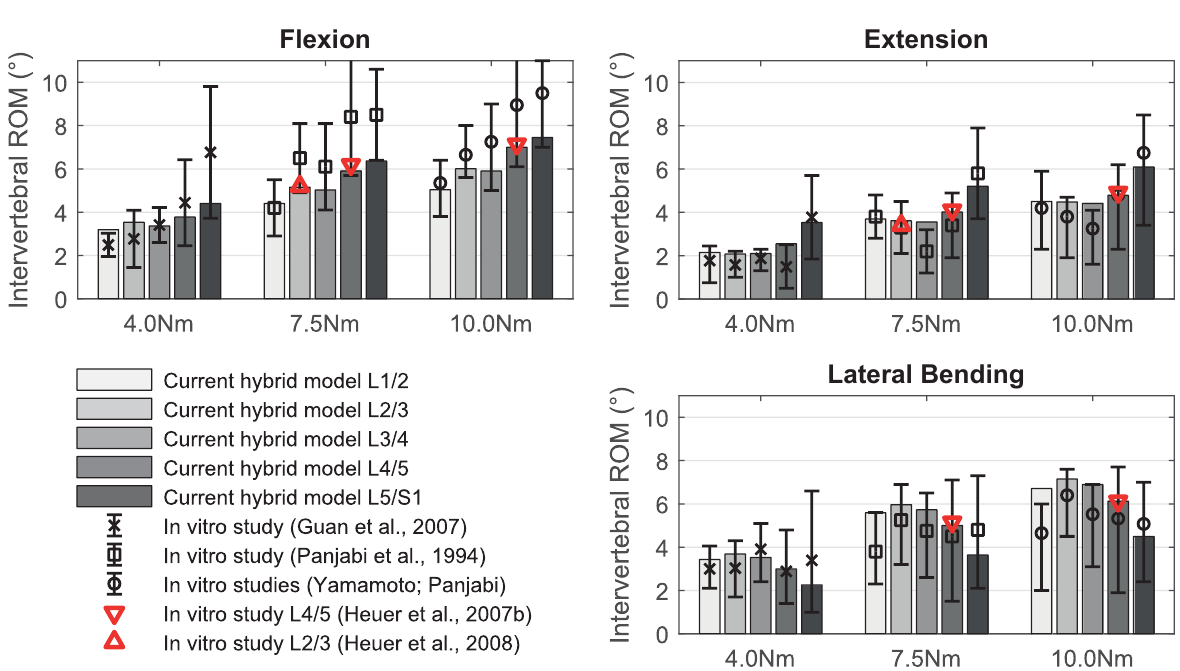
Fig 9. Intervertebral range of motion of the lumbosacral spine model loaded with pure moments. Comparison of our predicted intervertebral ROM in flexion, extension, and lateral bending (for axial rotation see S2 Fig in the appendix) with experimental in vitro data for completely tested LSS [127, 134, 140] and solely tested FSU [85, 130]. For comparison at 10 Nm the data of Yamamoto et al. and Panjabi et al. are combined.